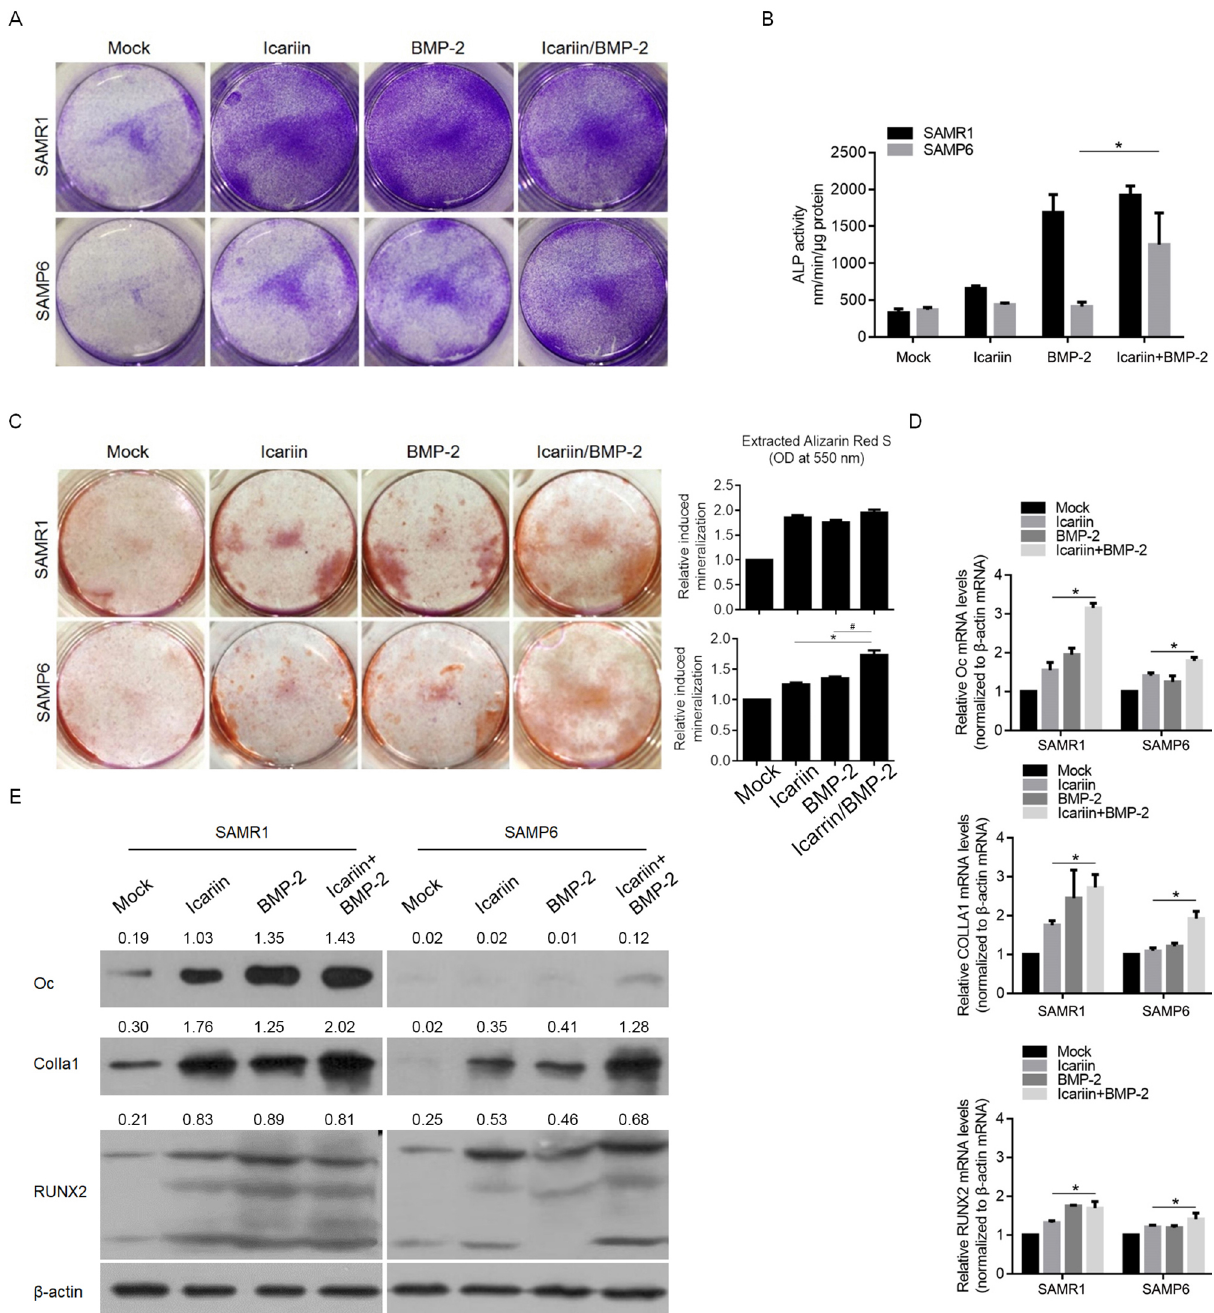
Fig 4. Icariin enhances maturation and mineralization in the presence of BMP-2 compared with SAMR1 osteoblasts. (A) After exposure to 10 μM icariin and BMP-2, ALP staining was performed. (B) ALP activity was measured after 10 μM icariin and BMP-2 treatment. (cid:3) P < 0.05 vs. Icariin group; #P < 0.05 vs. BMP-2 group. (C) Alizarin red S staining was performed to detect mineralization. (D) Semiquantitative Western blotting was performed to detect the protein levels of Runx2, collar I and OC after BMP-2 treatment. (cid:3) P < 0.05 vs. Icariin